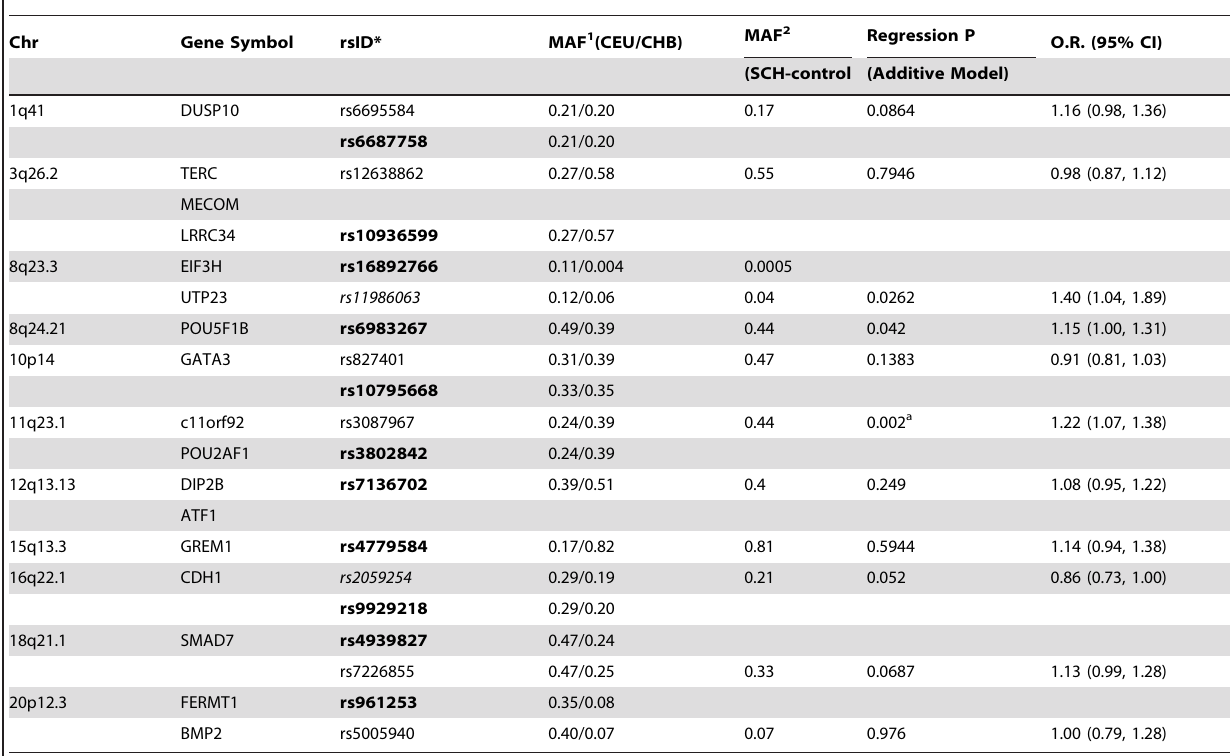
Table 2. Association of CEU-identified iSNP/sSNPs with CRC risk in